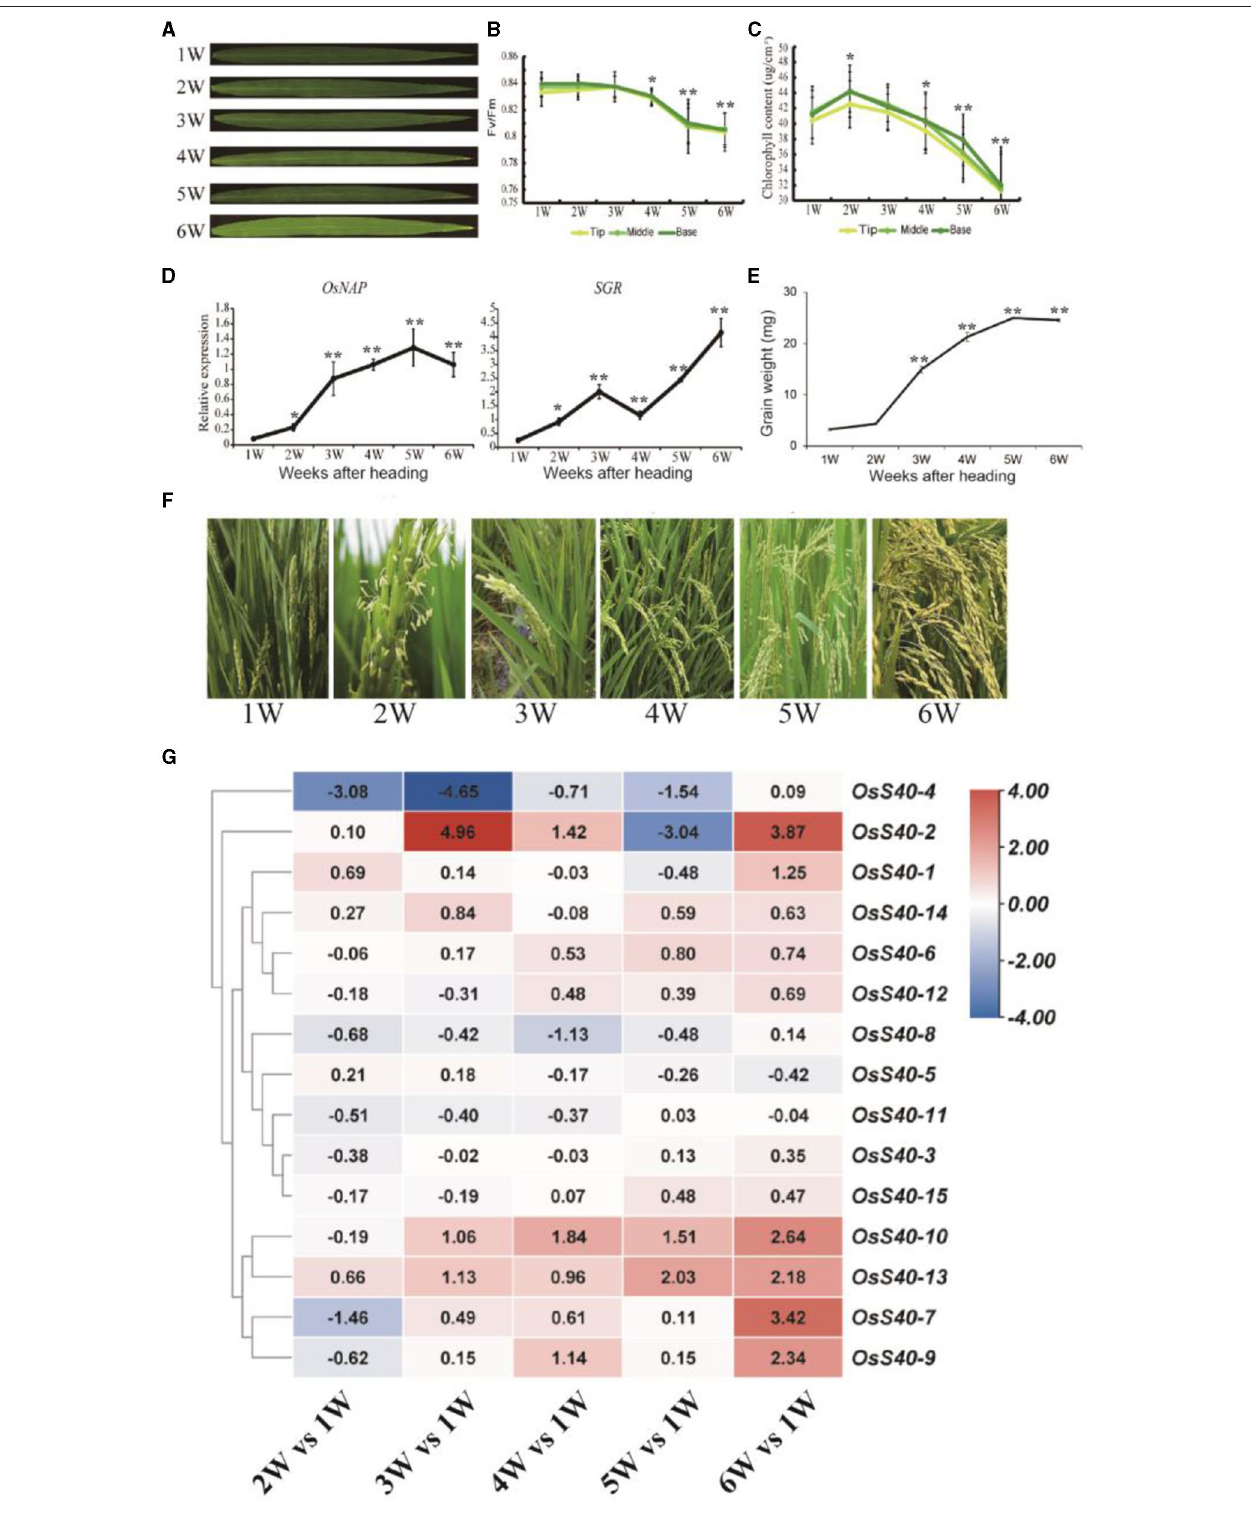
FIGURE 2 | The expression profiles of the OsS40 family from 1W (WAH) to 6W (WAH) during rice flag leaf aging (A) . The flag leaves during rice aging (B,C) . Photosystem II fluorescence efficiency (Fv/Fm) and chlorophyll contents of flag leaves during rice aging (D) . The senescence-related gene expression profiles of flag leaf during rice aging (E) . The grain weight during rice plant aging (F) . The whole plant of rice after heading during rice aging from 1W to 6W (G) . The expression profiles of the OsS40 family during rice flag leaf aging; values were the RPKM ratio normalized to 1W; mean and SD values were obtained from three biological replicates. Asterisks indicate significant differences (* p < 0.05; ** p < 0.01) based on Student’s t -test compared with 1W.